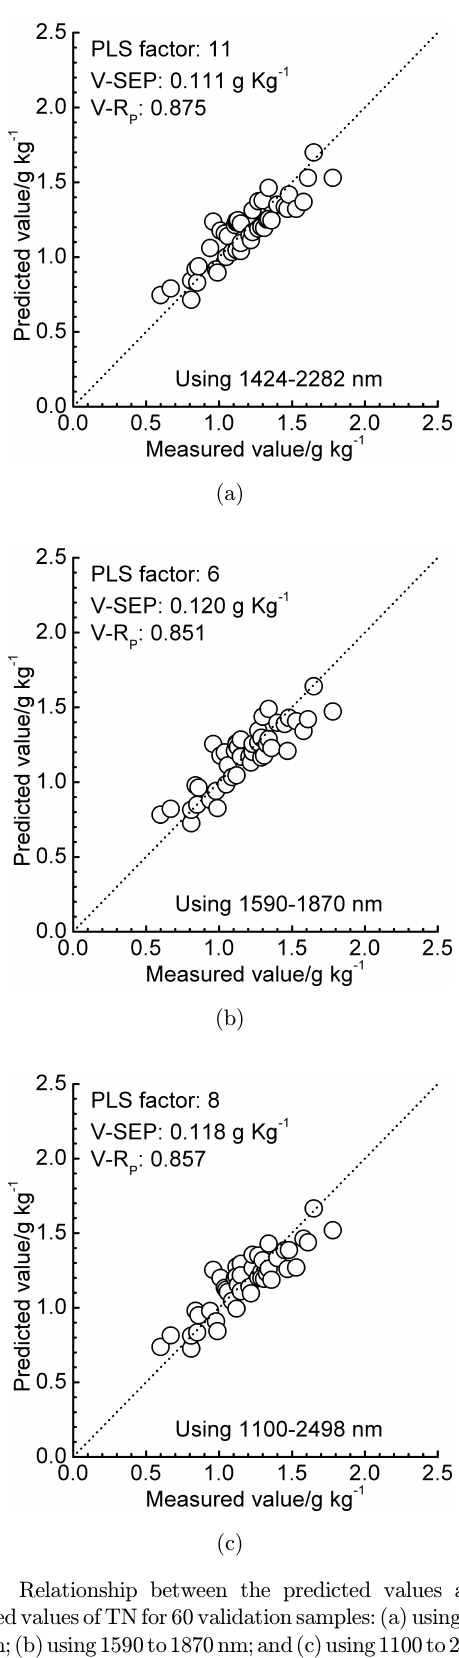
Fig. 7. Relationship between the predicted values and the measuredvalues of TNfor 60validation samples: (a) using1424to 2282nm;(b)using1590to1870nm;and(c)using1100to2498nm.